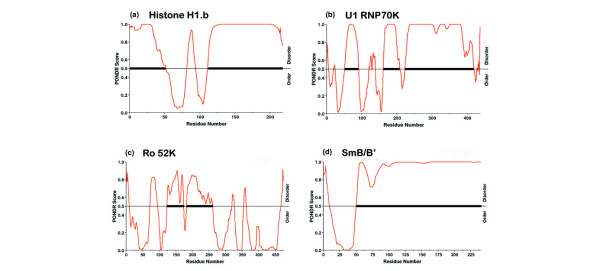
The PONDR® plot of several autoantigens selected from Table 1 (Additional file 1). The proteins shown are: (a) histone H1b (P10412); (b) U1 RNP70K (P08621); (c) Ro 52K (P19474); (d) SmB/B (P14678). The heavy horizontal black bars indicate regions of 39 or more successive disordered residues with a PONDR® score greater than the threshold of 0.5.